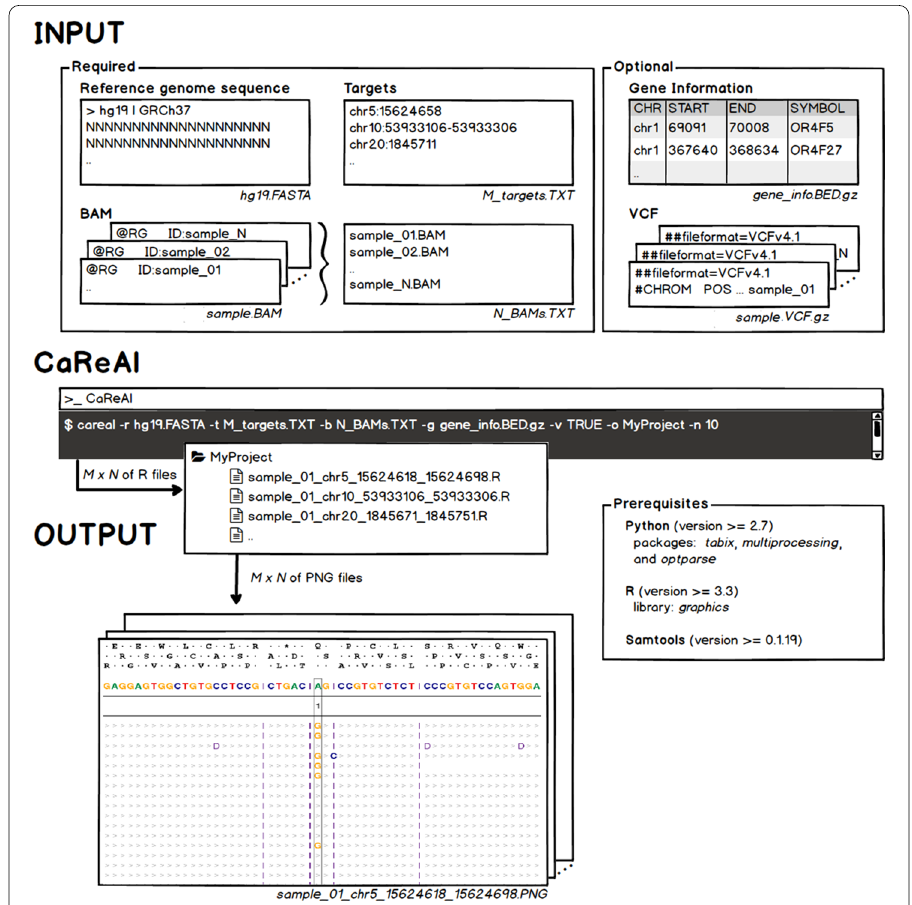
Fig. 1 A schematic description of CaReAl’s command-line interface and